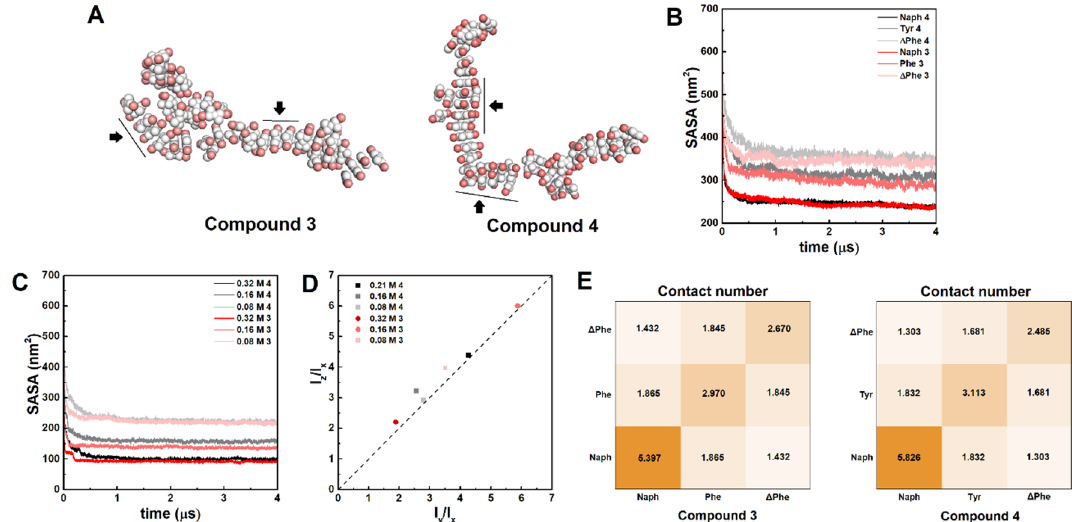
Figure 3. ( A ) Snapshot of the largest cluster resulting from the self-assembly of compound 3 and compound 4 , only depicting the 2,6-naphthalenedicarboxyl block. The arrows indicate stacking of the naphthalene moieties. Time evolution of the SASA for the ( B ) peptide residues and ( C ) aggregates in simulations of different concentration. ( D ) Moments of inertia of the clusters in the final snapshot for both compounds 3 and 4 in different concentrations, which for a one-dimensional aggregate: I x << I y ≈ I z . ( E ) Average contact number between different pairs of the compounds calculated from the last 2 µs of simulation.